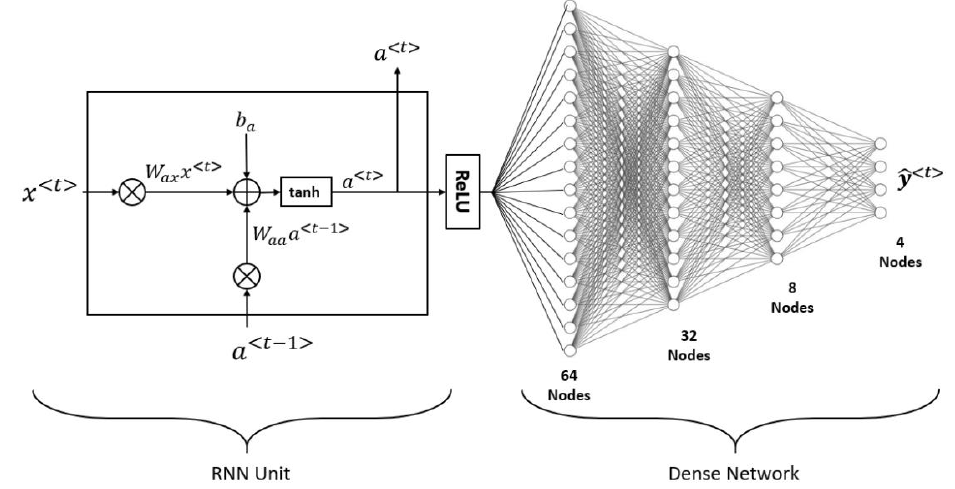
Figure 7. The overall architecture for